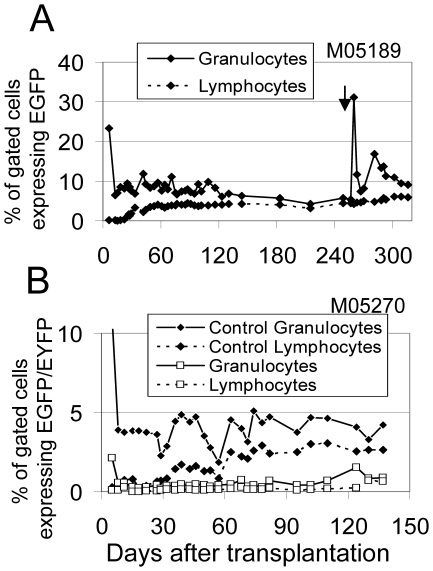
Transgene expression levels in peripheral blood cells of macaques and MGMT-mediated in vivo selection using O6BG and BCNU.The percentages of EGFP and EYFP-expressing leukocytes detected by flow-cytometry are shown for monkeys M05189 (A) and M05270 (B). Granulocytes and lymphocytes were gated based on forward and side-scatter properties and the percentage of EGFP or EYFP-expressing gated cells is shown. Administration of O6BG and BCNU to macaque M05189 is indicated by an arrow. For animal M05270 the control arm vector transduced cells are shown with back diamonds connected by a solid line (granulocytes) or dotted line (lymphocytes), and anti-HIV vector RSC-UsI-SC46-IMPGW transduced cells are shown by open boxes connected by a solid line (granulocytes) or dotted line (lymphocytes).